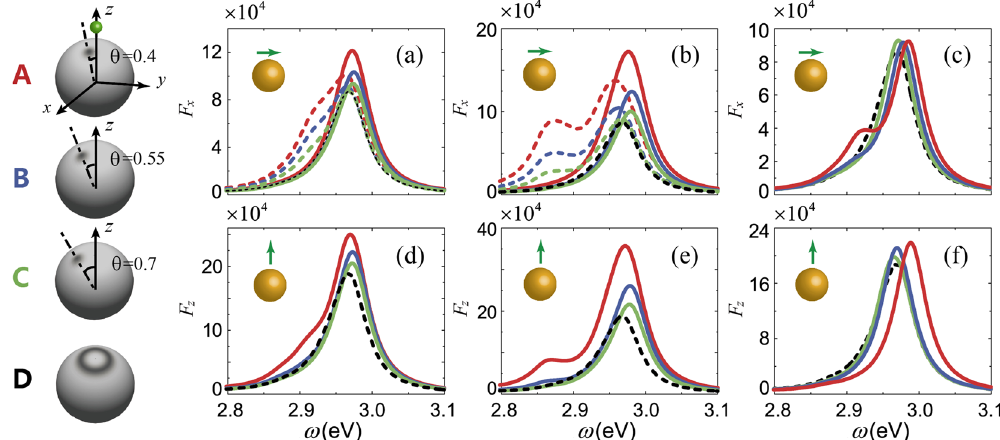
Figure 3. F i of idealized MNP with a bump. Left: models of idealized MNP with a bump located along the x-direction for θ = 0.4 rad ( A ), θ = 0.55 rad ( B ) and θ = 0.7 rad ( C ). Green dot in ( A ) represents the dipole. ( D ) is the modal of an idealized MNP with ring bump. Right: (a) F x of MNP with a 0.5 nm-high-bump along the x-direction (dashed line) and y-direction (solid line) using an x-oriented dipole for θ = 0.4 rad (red line), θ = 0.55 rad (blue line) and θ = 0.7 rad (green line). (b) is the same as (a) except that the bump has 1.0-nm height. (c) F x of MNP with a ring bump with 0.5-nm height using an x-oriented dipole for θ = 0.4 rad (red line), θ = 0.55 rad (blue line) and θ = 0.7 rad (green line). (d–f) shows results for a z-oriented dipole with the other parameters being the same as those in (a–c). F i of idealized MNPs without a bump is shown for comparison (black dashed line).